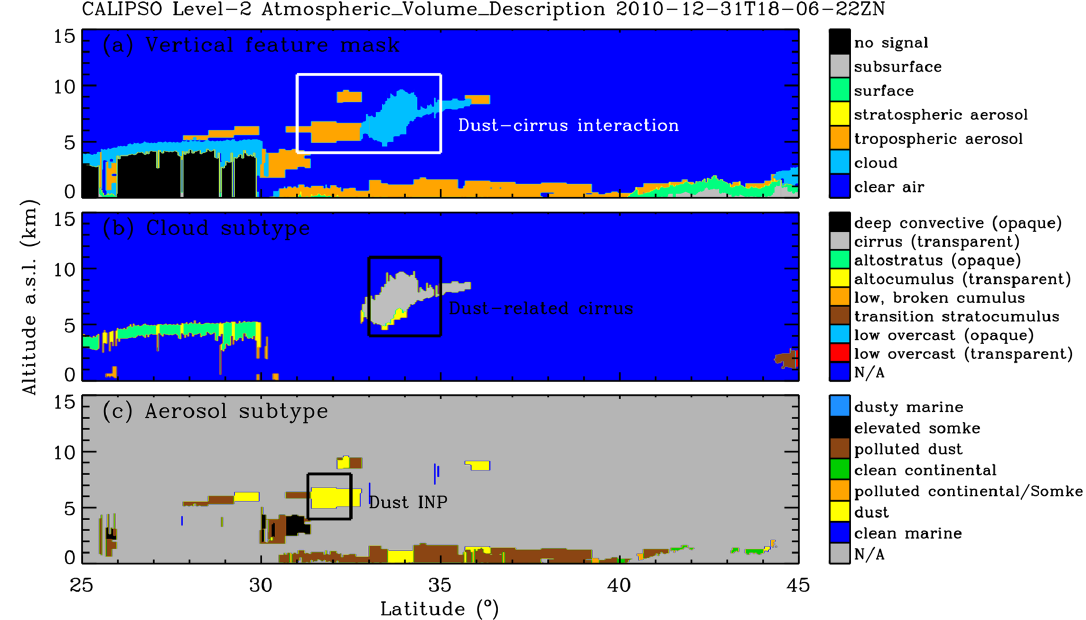
Figure 8. CALIPSO altitude–orbit cross section measurements of the CALIOP Level-2 (a) vertical feature mask, (b) cloud subtype, and (c) aerosol subtype product on 31 December 2010. The corresponding orbit is 2010-12-31T18-06-22ZN. The footprint of the satel- lite is the same as shown in Fig. 7.